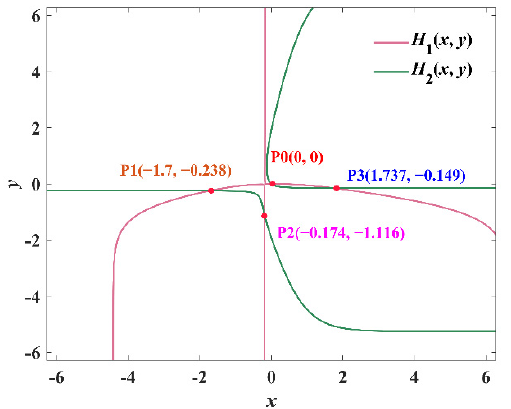
Figure 6. Equilibria of the memristive HNN, i.e., the intersection points of H 1 and H 2 .